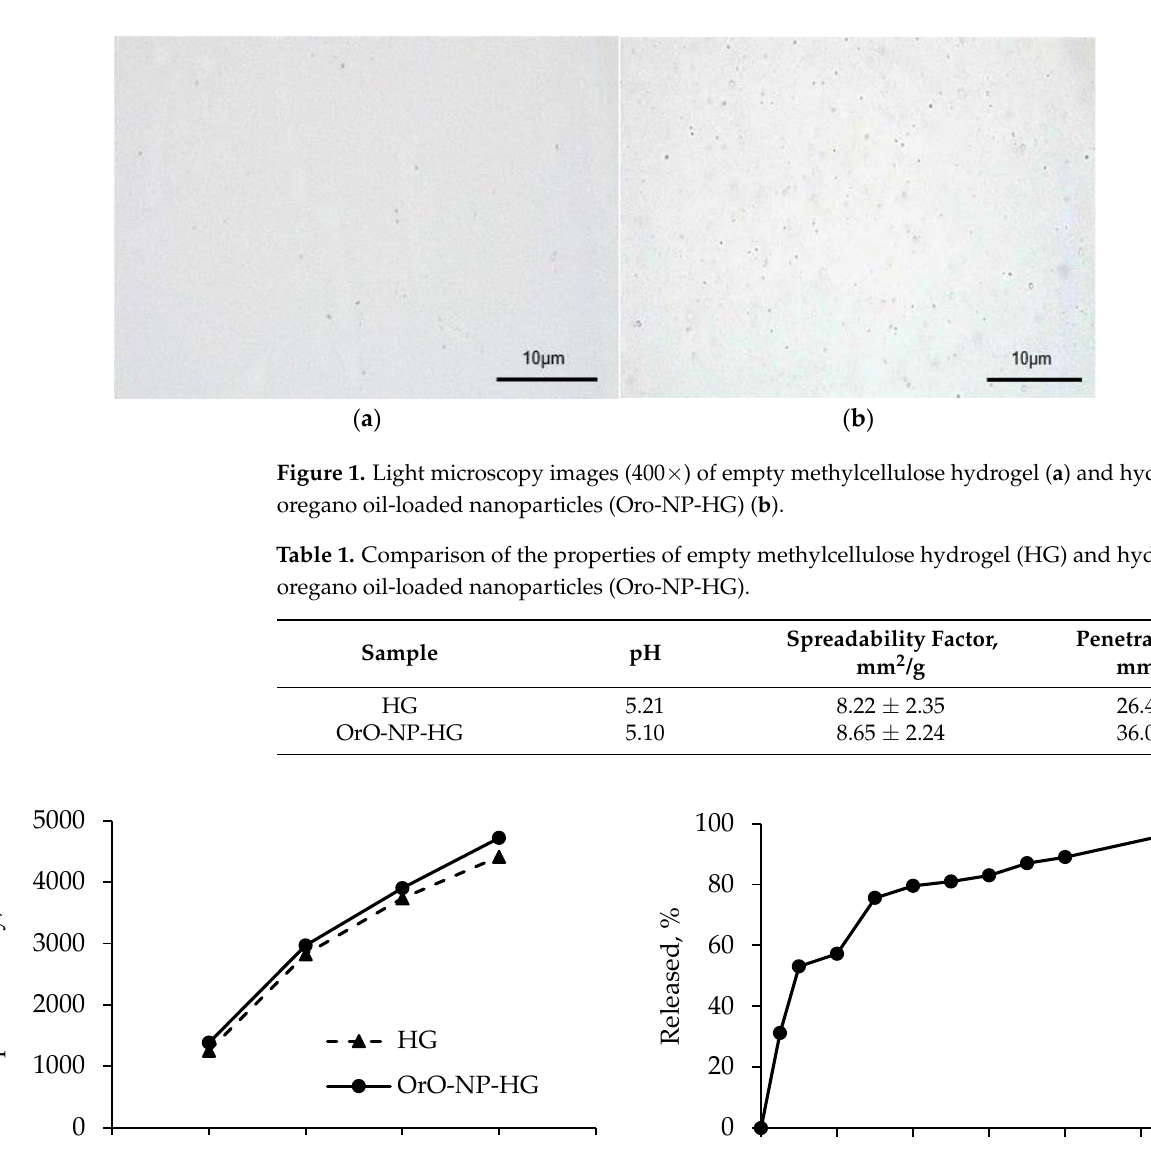
Table 1. Comparison of the properties of empty methylcellulose hydrogel (HG) and hydrogel with oregano oil-loaded nanoparticles (Oro-NP-HG).